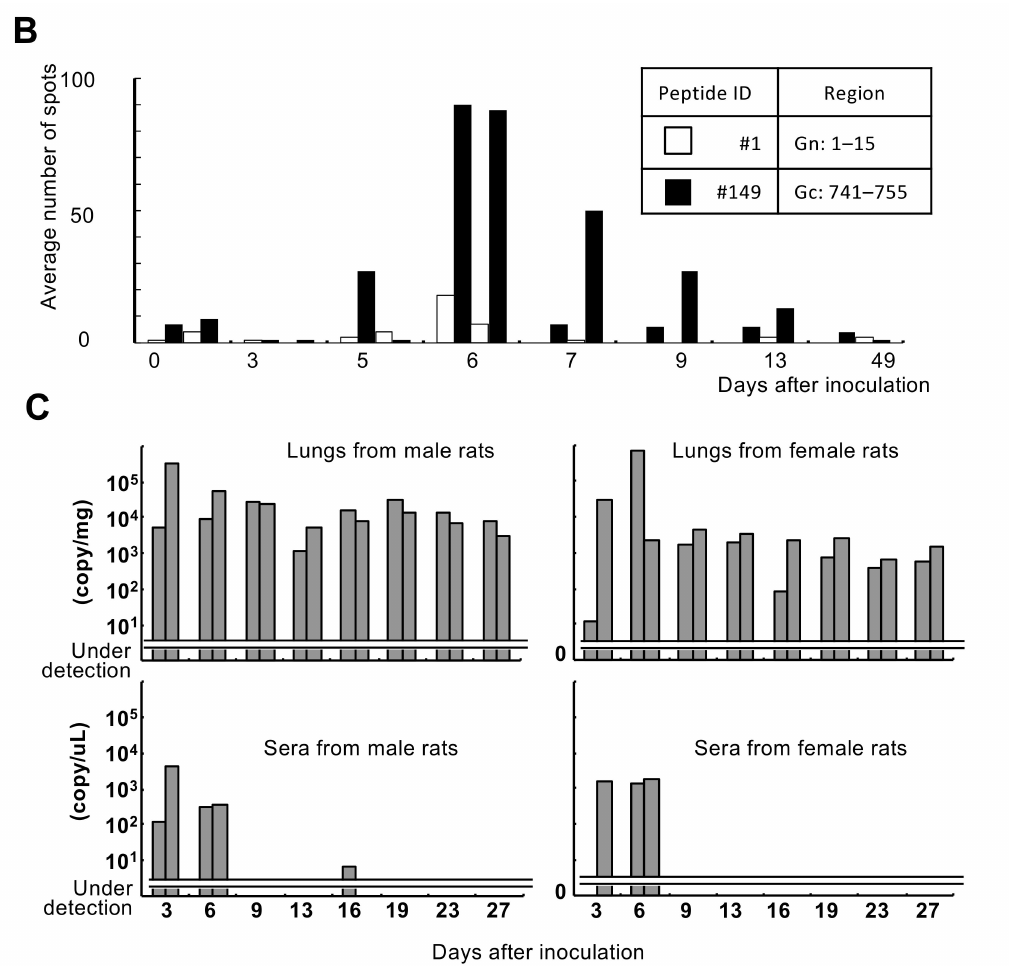
Figure 1. Immunological responses and virus replication in Seoul orthohantavirus (SEOV)-inoculated WKAH/hkm rats. ( A ) Fluctuations of IgM and IgG antibodies and IgG avidity index in rat sera. Circles, ELISA OD for IgM antibody detection; squares, ELISA OD for IgG antibody detection; triangles, IgG avidity %. Open markers are results from rat #1 and closed markers are results from rat #2. ( B ) Results of the ELISPOT assay. Two rats were examined by the ELISPOT assay by using control peptide #1 and epitope peptide #149. ( C ) Viral replication in lungs and sera was determined by a real-time PCR assay. Two rats were examined at each time